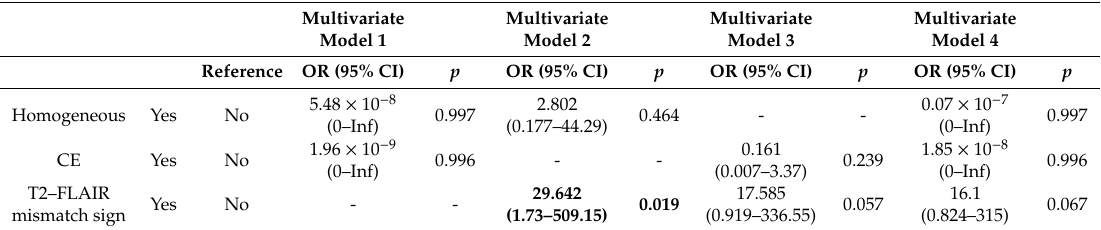
Table 4. Multivariate logistic regression analysis of four models. No parameter retained its statistical significance in any multivariate model, except for the T2–FLAIR mismatch sign when co-registered with tumor homogeneity.